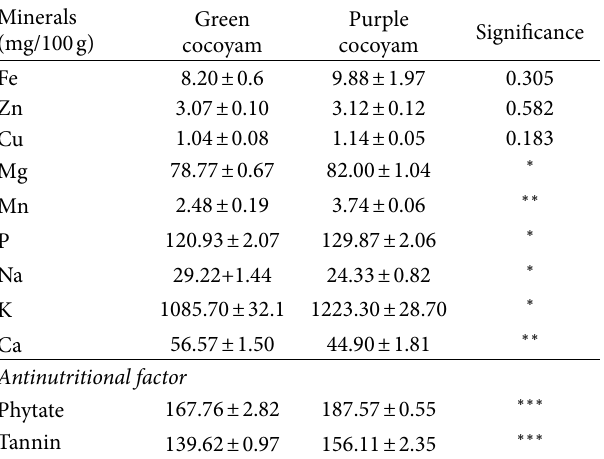
Table 2: Mineral contents and antinutritional factors of green- and